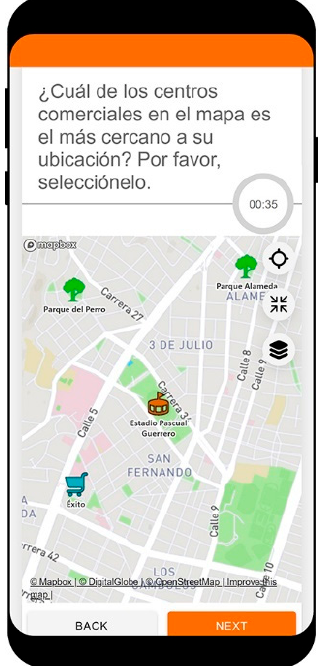
Figure 1. Example of a map-reading task with a respective question and map design (English translation: “Which shopping mall is the closest to your location? Please select one.”)